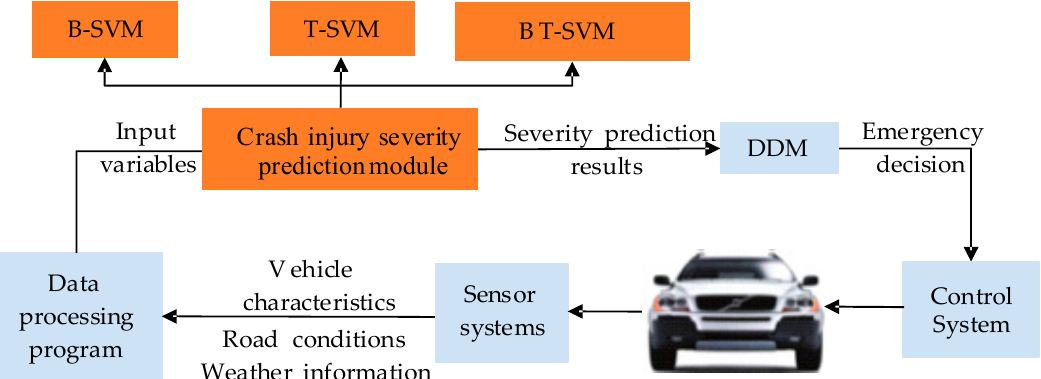
Figure 1. Emergency decision-making process of autonomous vehicles under emergency situation. (B-SVM, T-SVM, and BT-SVM refer to the SVM crash injury severity prediction model corresponding to braking, turning, and braking + turning, respectively, i.e., braking-support vector machine, turning-support vector machine, and braking + turning-support vector machine).